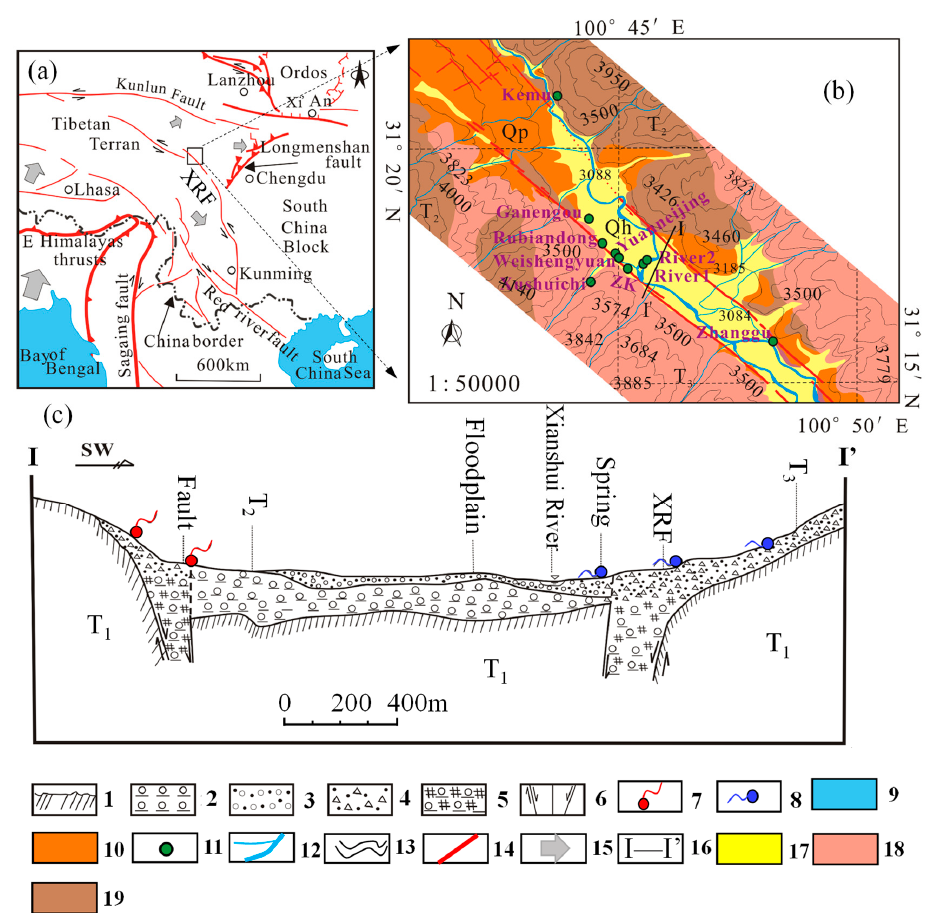
Figure 1. ( a ) Location of the Xianshui River fault and the study area (inside the small rectangular area), ( b ) geological map with the sampling points, ( c ) the cross section of I–I’ in ( b ) (1. the Upper Triassic; 2. the Middle Triassic; 3. Alluvium of the upper Pleistocene–Holocene; 4. the Lower Triassic; 5. bedrock fractured zone; 6. fault; 7. geothermal spring; 8. cold spring; 9. sea; 10. Qp and 17. Qh represent different layers of the Quaternary; 11. sampling sites; 12. streams; 13. elevations; 14. faults; 15. direction of movements; 16. cross-section; 18. T3; 19. T2.) (Figure 1c was modified after